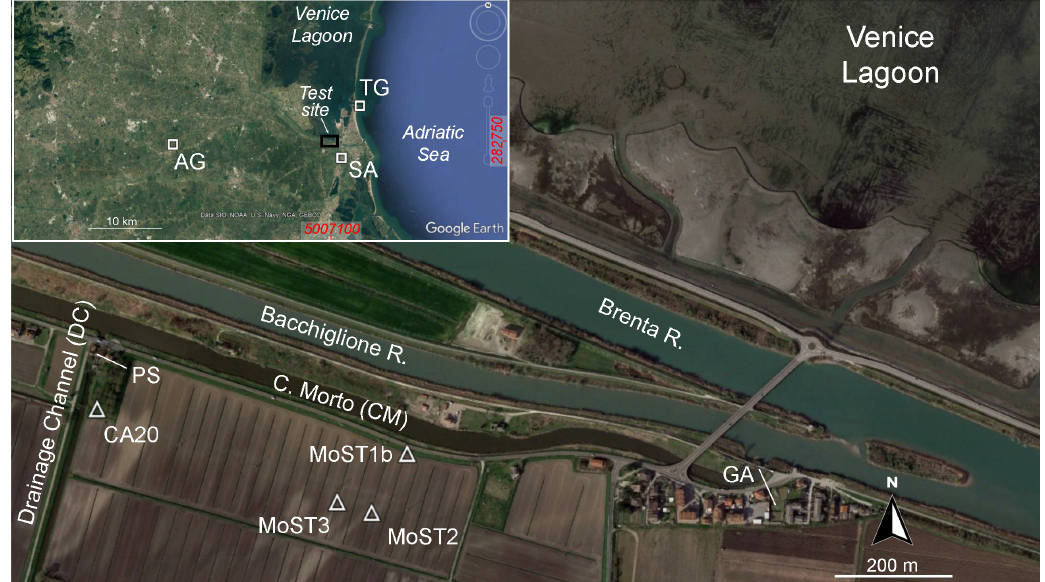
Figure 3. The southern Venice lagoon—coastal area test site with the location of the piezometers (MoST1b, MoST2, MoST3, and CA20), the monitoring points of the surface water levels of the drainage channel (DC) controlled by the pumping station (PS), and the Canal Morto (CM). SA and AG are the locations of meteorological stations, Sant’ Anna and Agna, respectively, while Chioggia tide gauge station is denoted by TG and GA indicates gates at